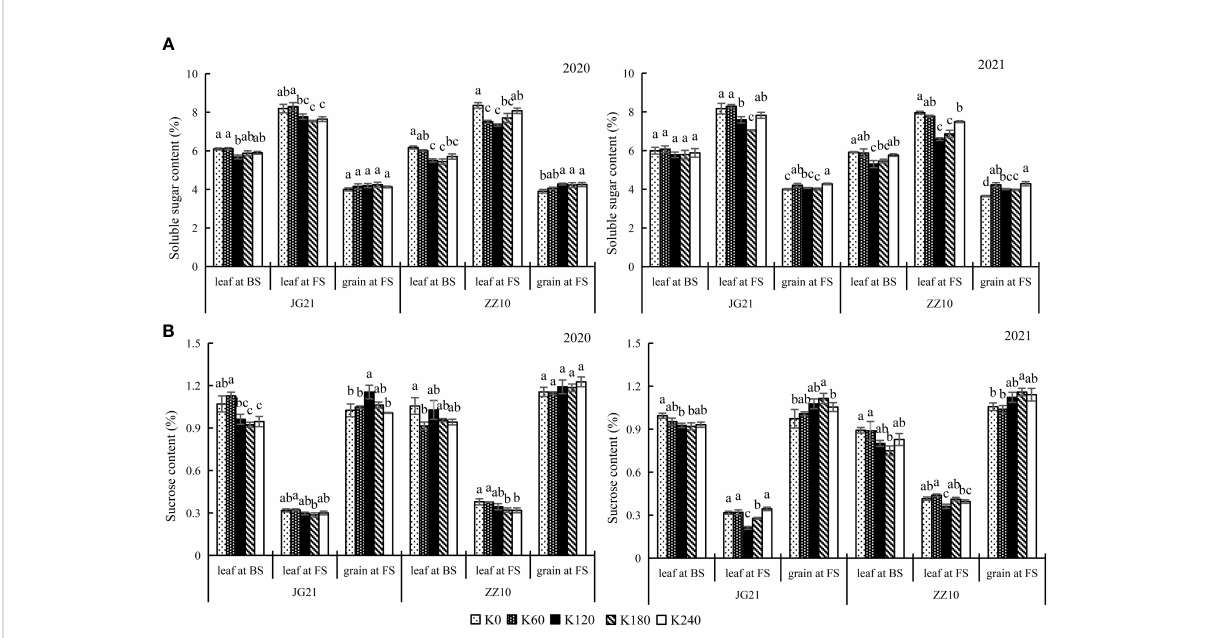
FIGURE 5 Effects of potassium application rate on soluble sugar and sucrose content of foxtail millet cultivars, Jingu 21 (JG21) and Zhangza 10 (ZZ10). Potassium applications include 5 level 0 (K 0 ) as control, 60 (K 60 ), 120 (K 120 ), 180 (K 180 ), and 240 (K 240 ) kg·hm − 2 of K 2 O. BS, booting stage, FS, fi lling stage. The different normal letters indicate signi fi cant differences in different treatments of the same variety at the 0.05 level. Values are means ± SE (n = 3). (A) soluble sugar content. (B) sucrose